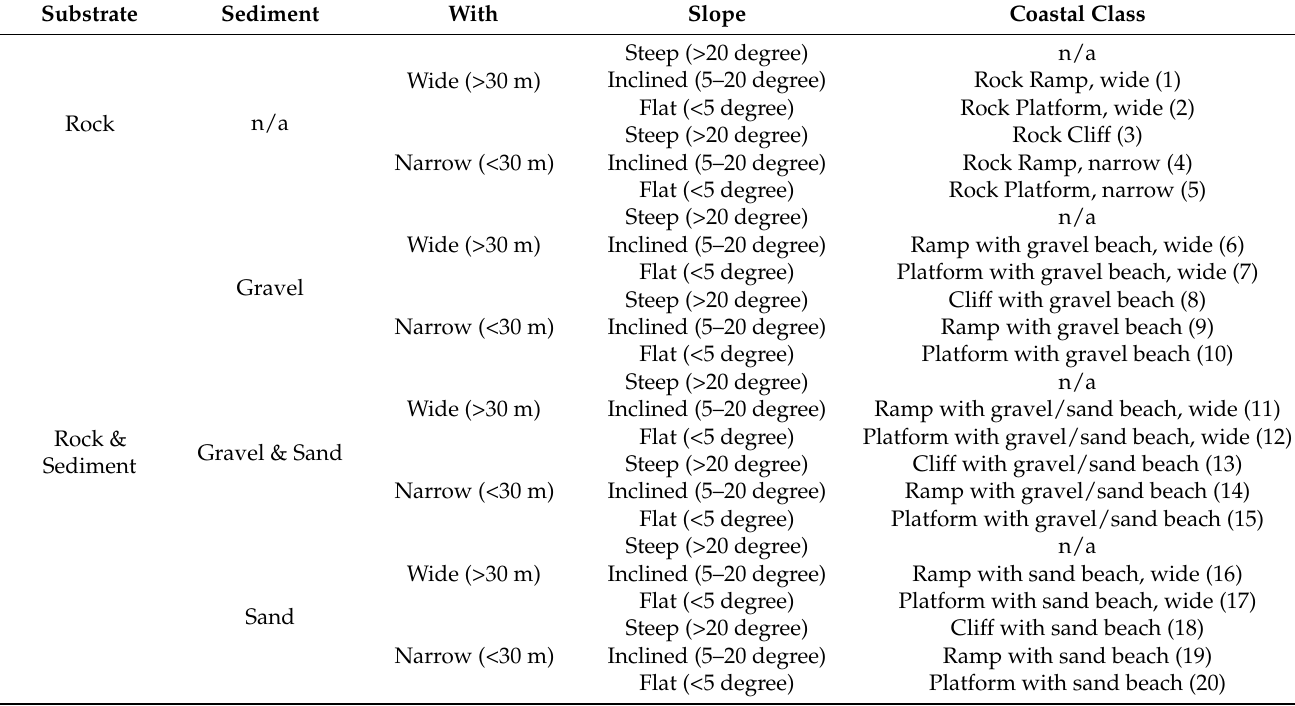
Table A1. Summary of shore zone